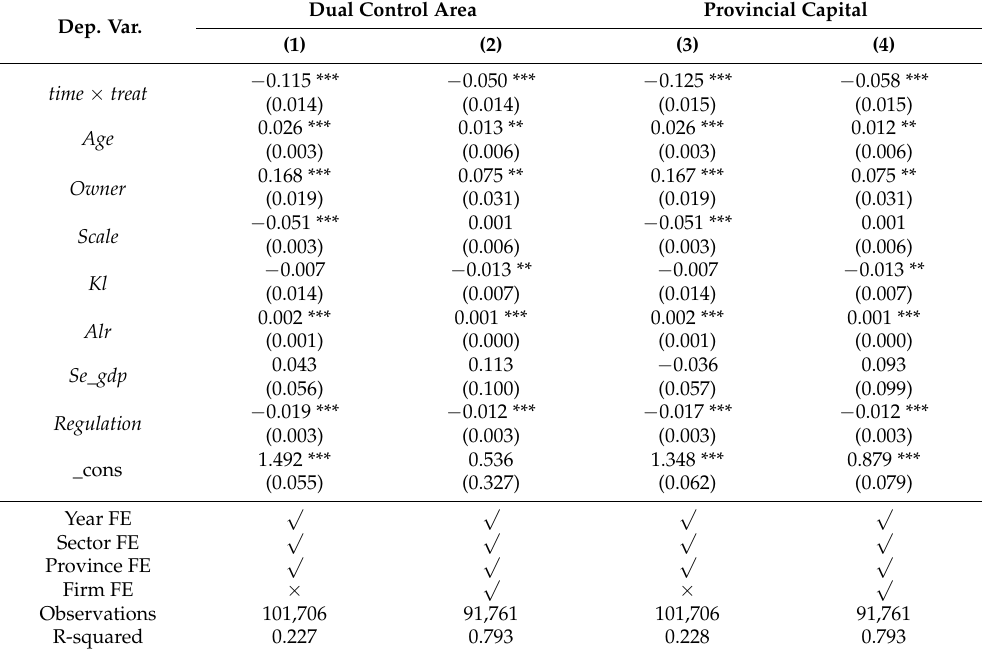
Table 7. Adding benchmark variables alleviates the impact of selection. Dep.